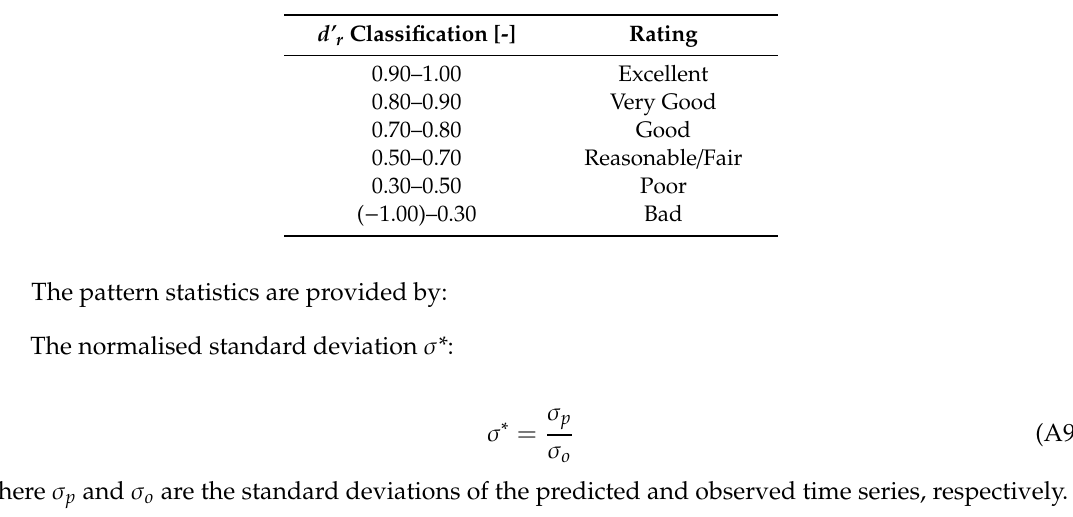
Table A1. Proposed classification of the relative refined index of agreement d’ r and corresponding rating. Reproduced from [3], with permission from the authors,